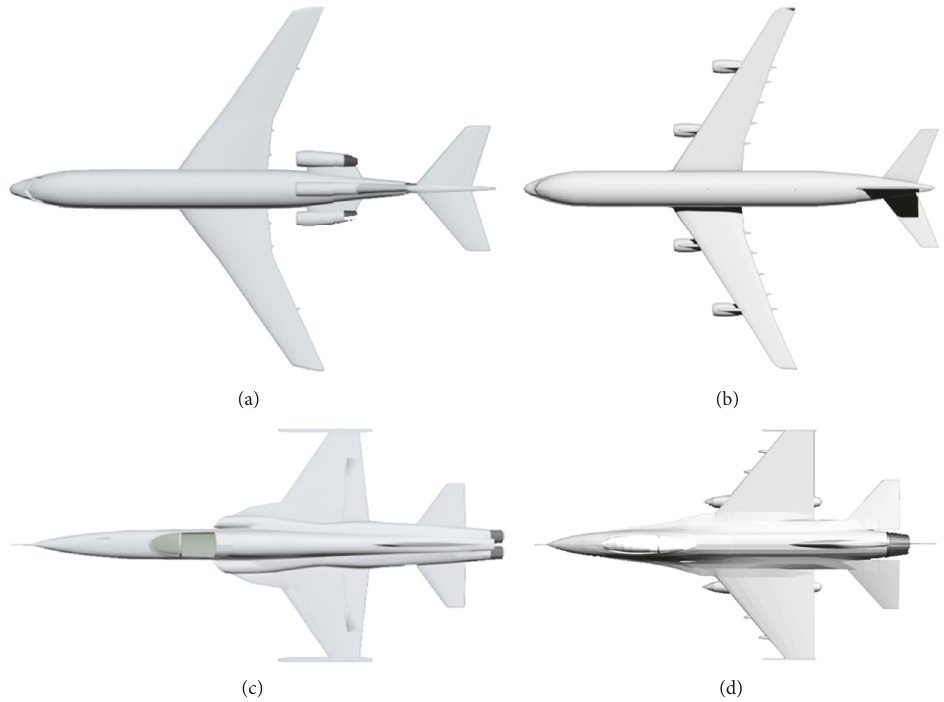
Figure 1: Four 3D models of the targets: (a) Target 1, (b) Target 2, (c) Target 3, and (d) Target